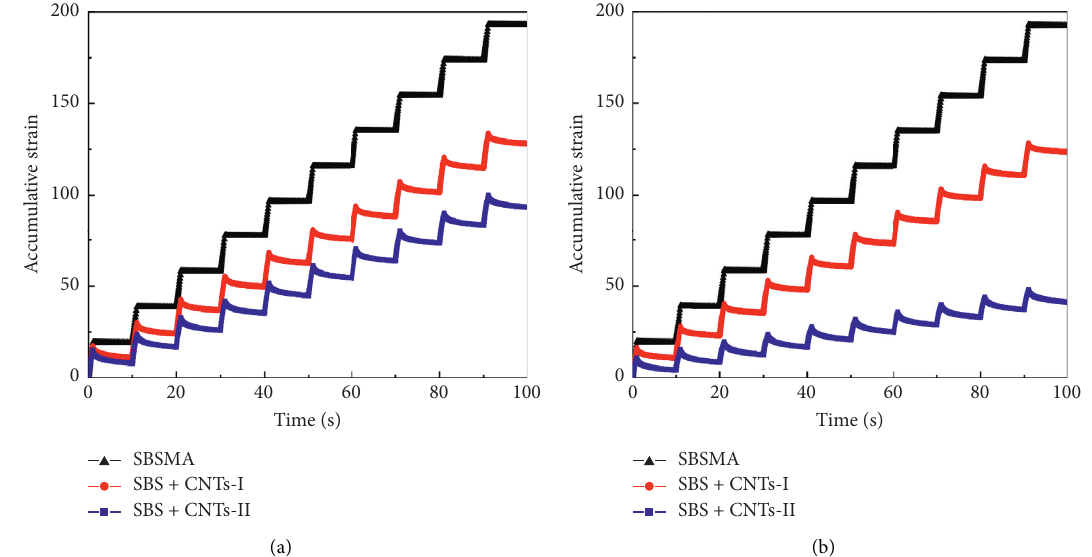
Figure 10: Accumulative strain at 3200Pa of the three modified asphalts stored on the 10th day. (a) The rules of asphalt samples at the top. (b) The rules of asphalt samples at the bottom.